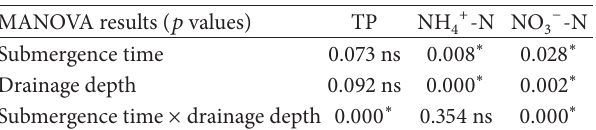
Table 3: MANOVA results for the change of concentration of TP, NH 4+ -N, and NO 3− -N.